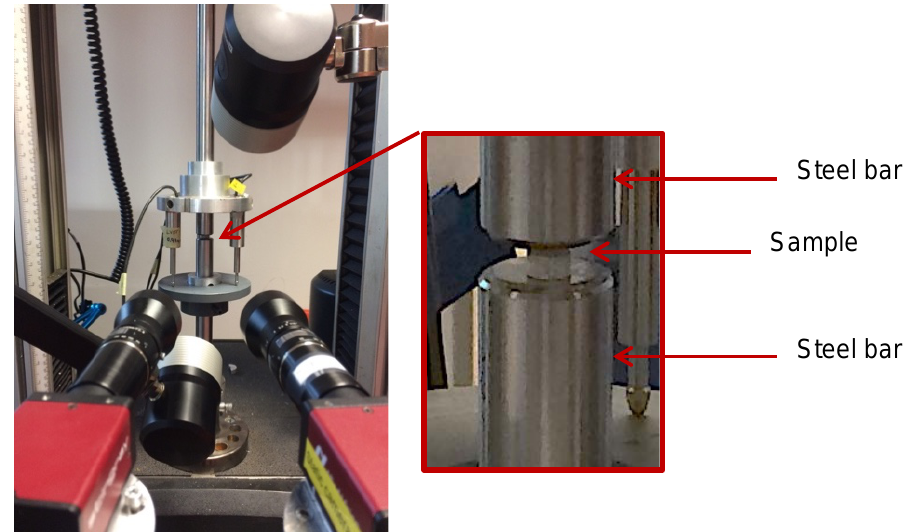
Figure 4. Quasi-static setup used with digital image correlation (DIC) and displacement transducers with detail on sample positioning.